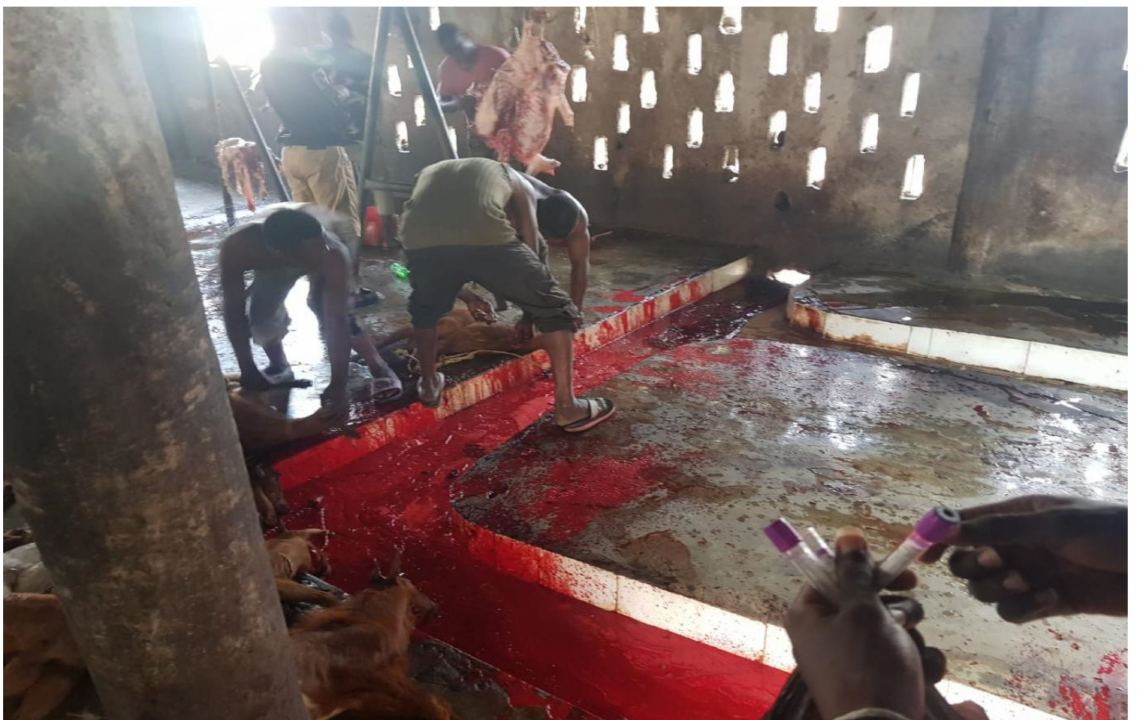
Figure 6. Typical abattoir in Nigeria showing butcher slaughtering animals without personal protec- tive